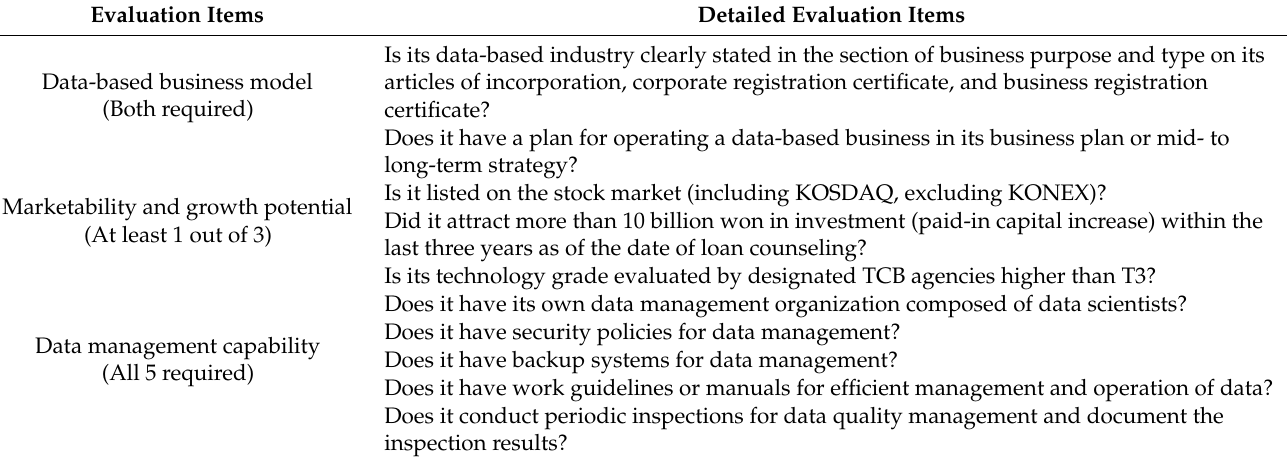
Detailed Evaluation